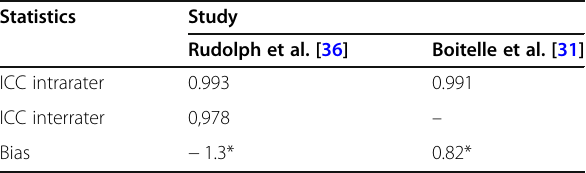
Table 5 Summary of findings of other